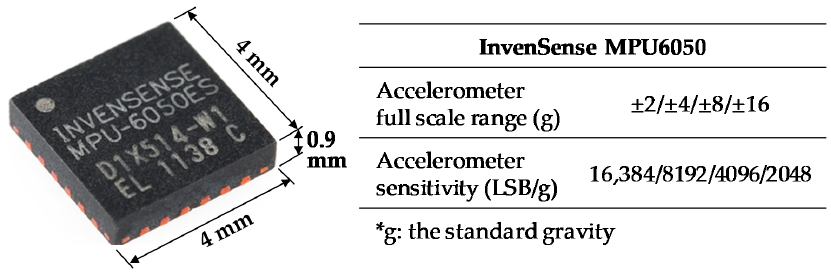
Figure 1. InvenSense microprocessor unit 6050 (MPU6050) and its main parameters [19].